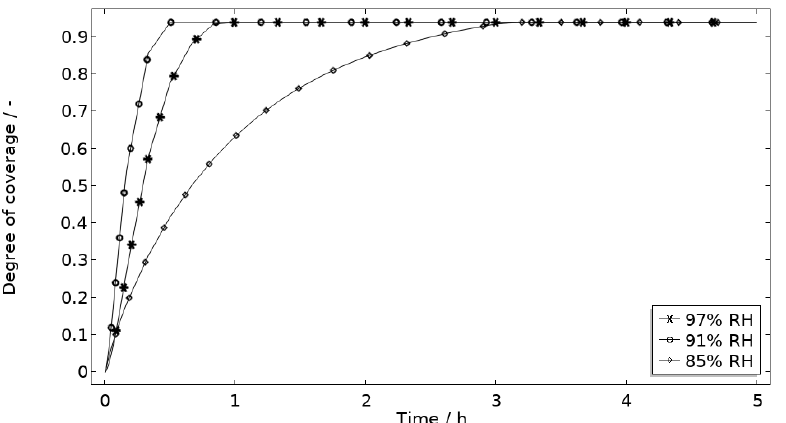
Figure 14. Modeled degree of coverage of the corroding surface ( θ all ) during 5 h exposure of the calibration cell with 86 μ g NaCl/cm 2 load at 21 °C at 85%, 91%, and 97% RH.